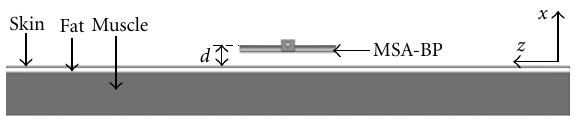
Figure 8: Configuration of the MSA-BP on a trilayer arm phantom.